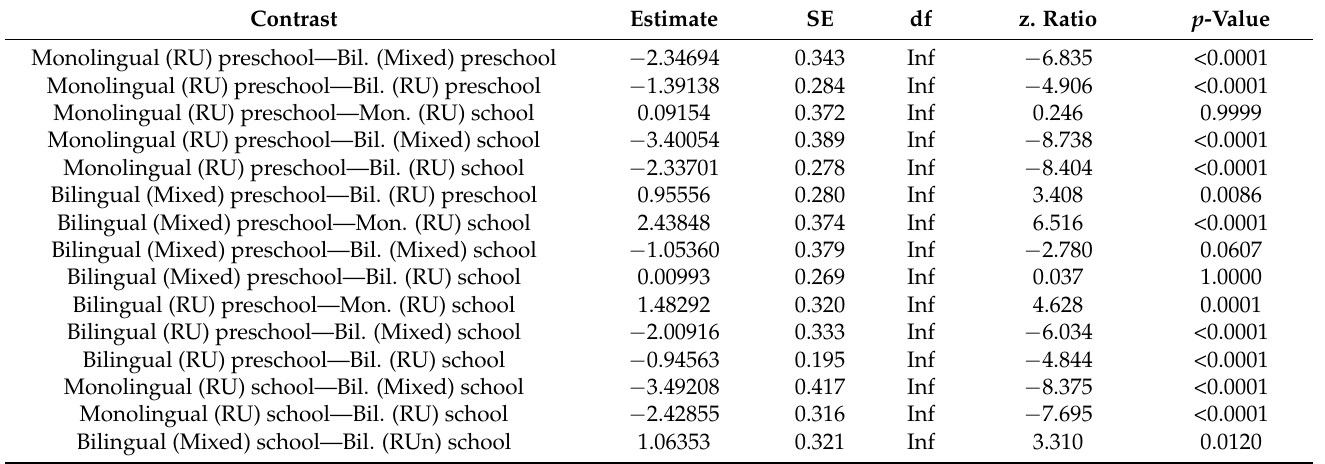
Table A1. Russian experiment: pairwise comparisons, age group by family type (subset). Contrast Estimate SE